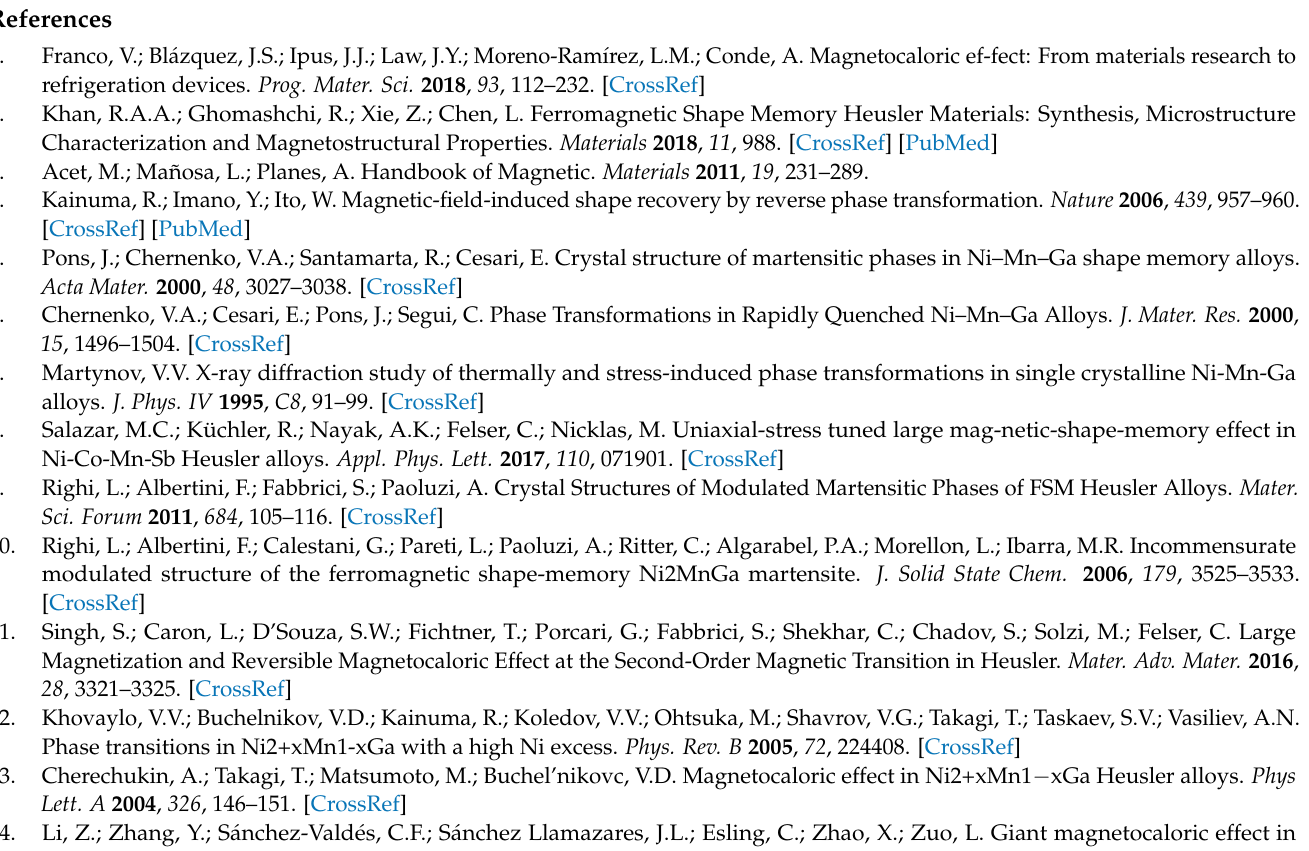
alloy, Figure S2: Rietveld plot based on neutron diffraction data for the austenitic phase at 350 K. Figure S3: Ferromagnetic orientation of the spins located on the Mn/Ni site of the orthorhombic body centered lattice. Table S1: Crystal data of austenitic phase at 350 K, Table S2: Atomic coordinates, occupancy factors and thermal parameters for the cubic austenite at 350 K. Table S3: Crystal data of the modulated martensitic phase based on the structural refinement of the neutron diffraction data collected at 220K. Table S4: Atomic coordinate, occupancy factors, thermal parameters and modulation parameters A1x for the martensite at 220